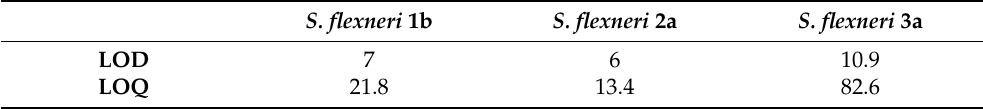
Table 3. LoD and LoQ for each of the three S. flexneri serotypes